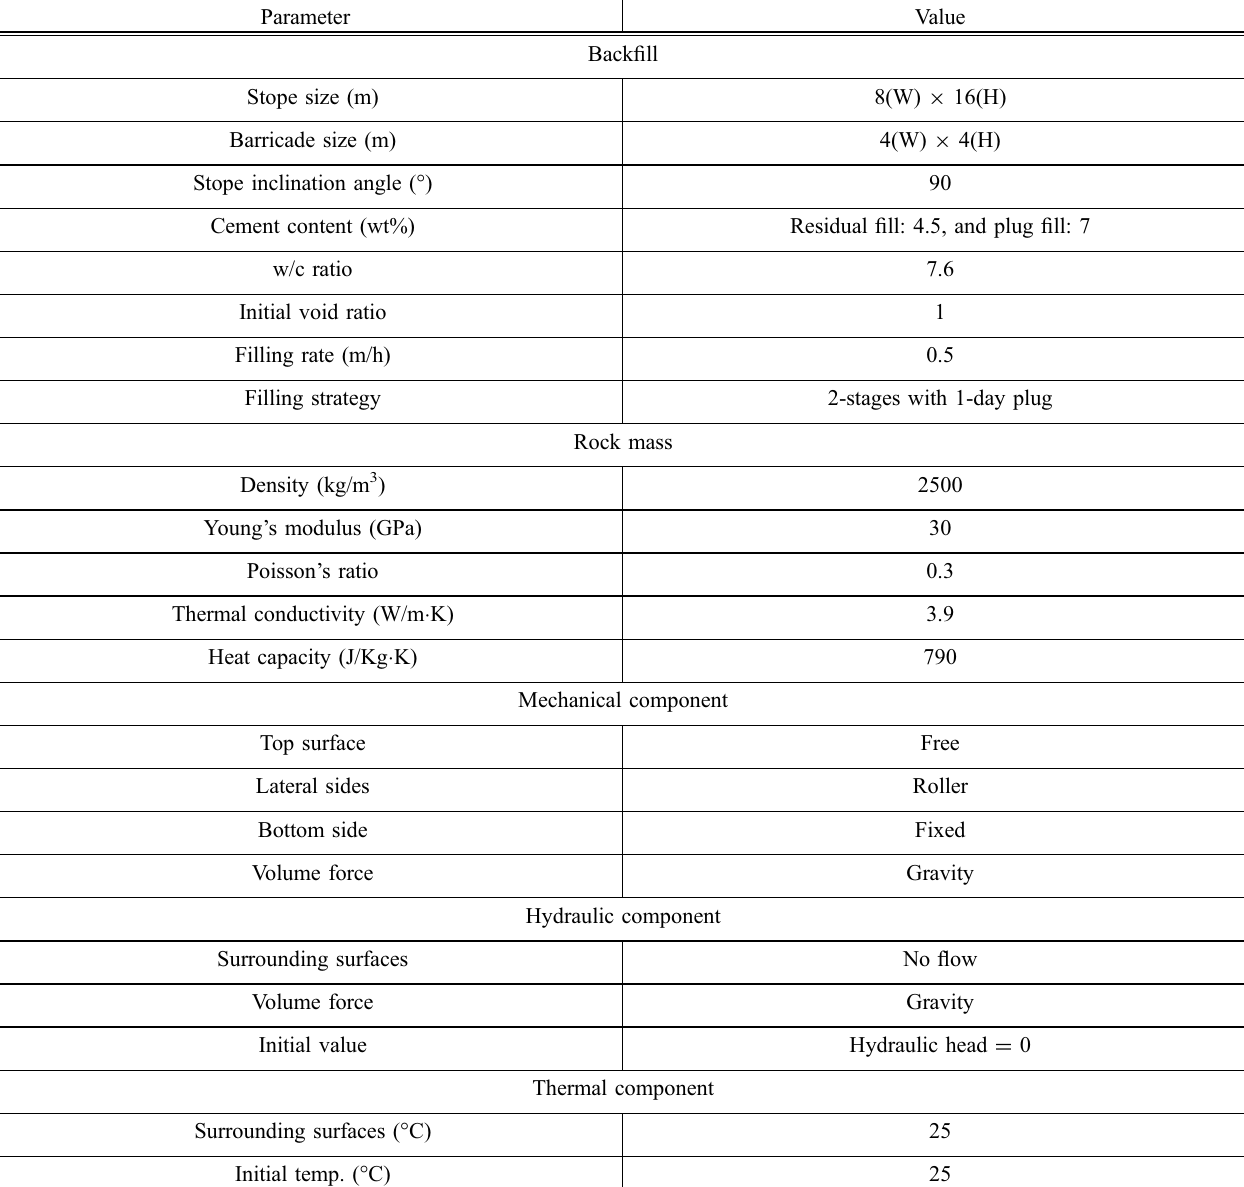
Table 8 Input parameters, initial values and boundary conditions of control CPB and rock